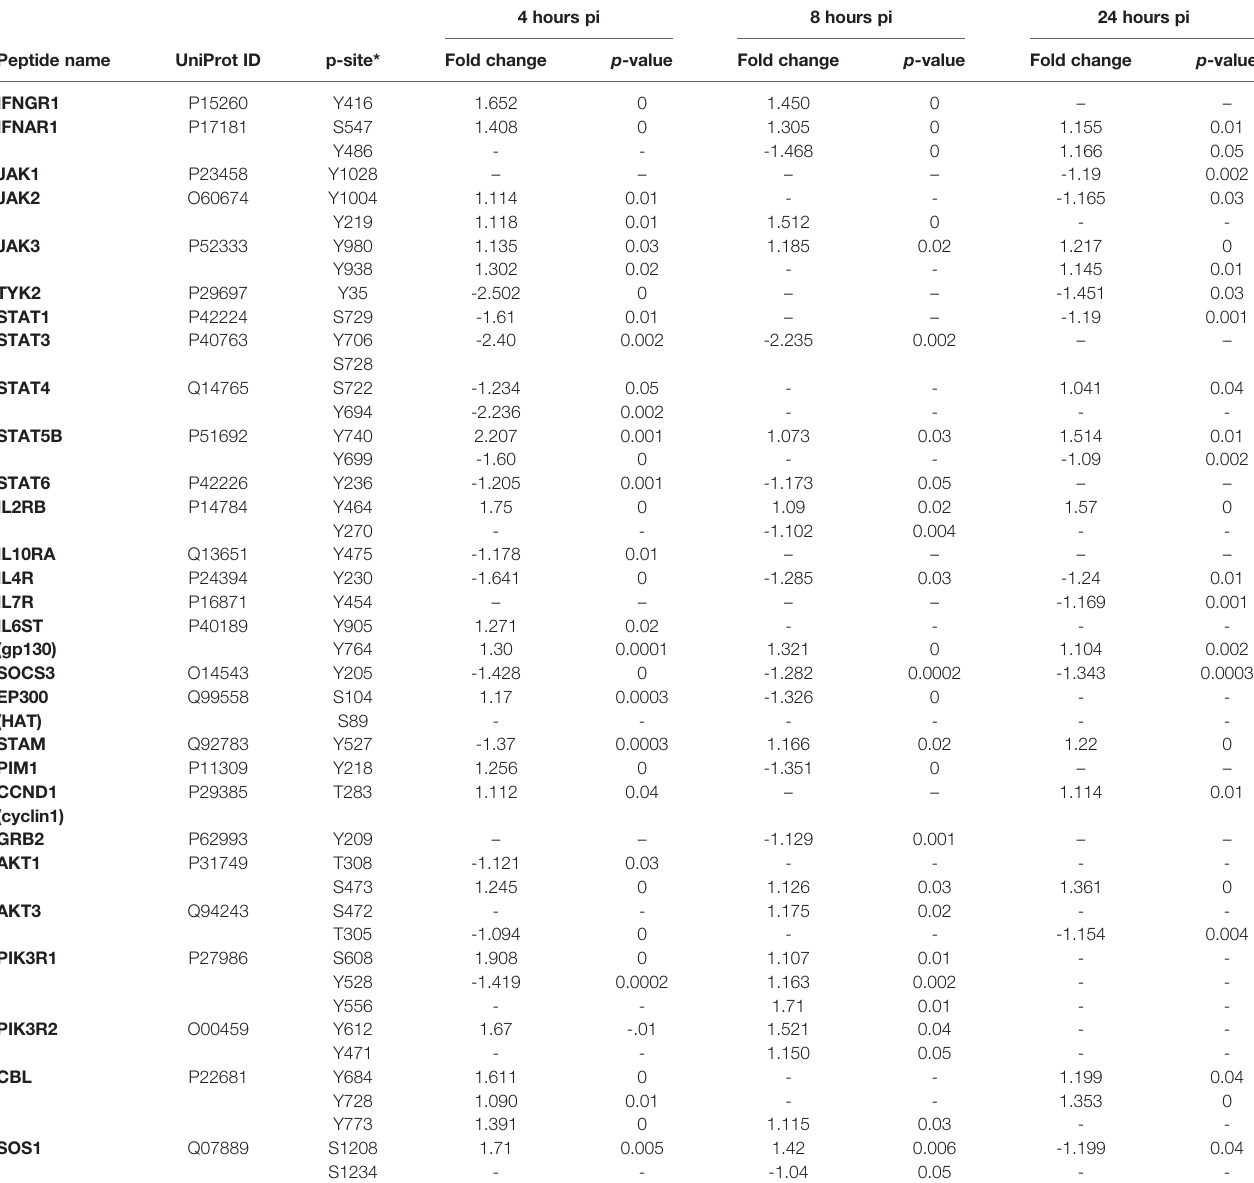
TABLE 8 | Members of the JAK-STAT signaling pathway showing differential phosphorylation between Salmonella enterica serovar Enteritidis-infected cecal tissue and non-infected cecal